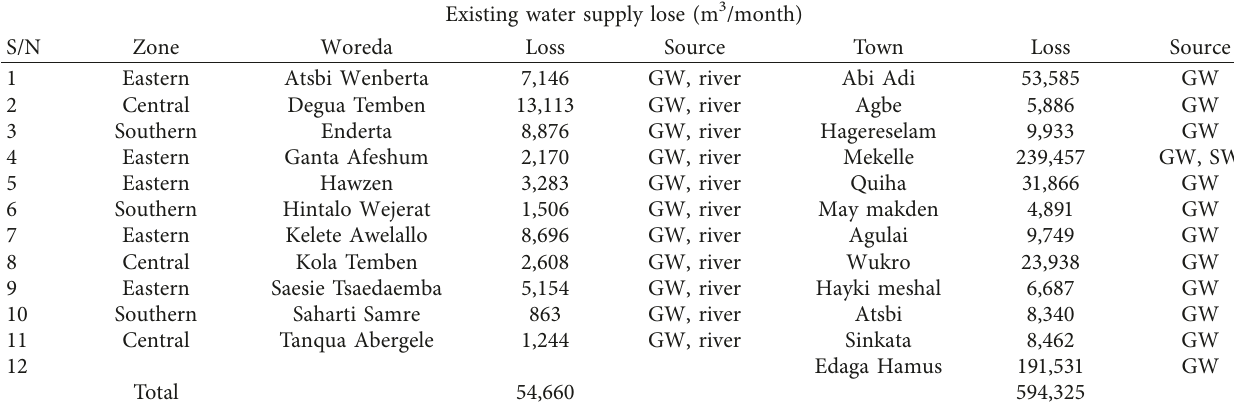
Table 8: Estimated current real water loss of urban and rural areas in the Ghba